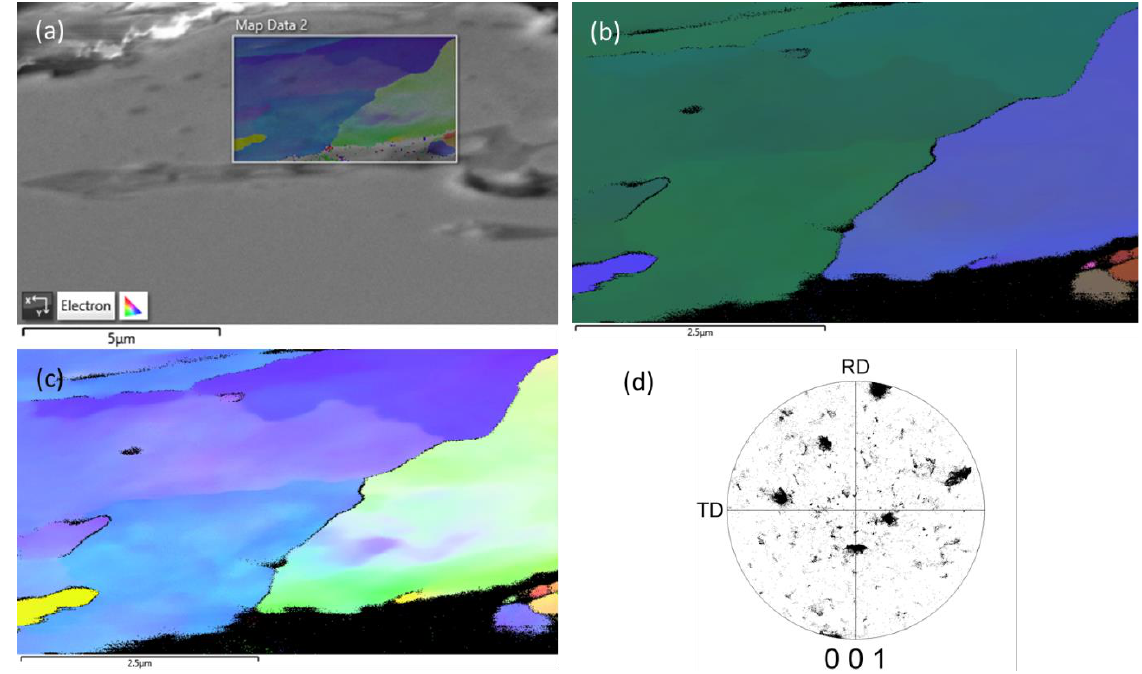
Figure 5. EBSD investigation of the recast layer: ( a ) Electron image with overlay map area, ( b ) image quality (IQ) map, ( c ) inverse pole figure (IPF) map, and ( d ) pole figure (PF) map.